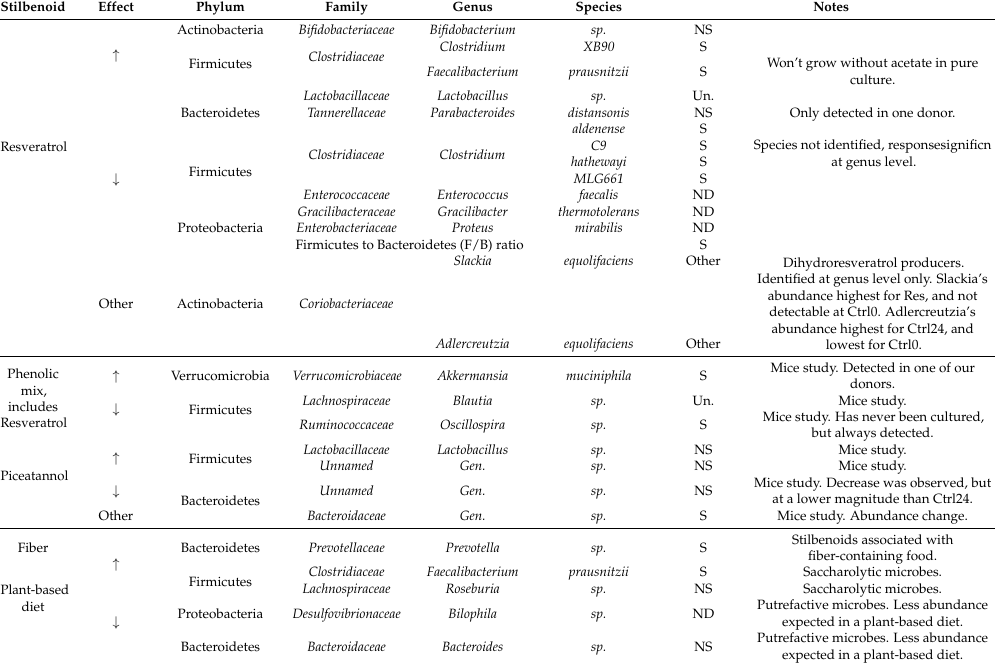
Table 2. Observations from previous studies regarding the effect of select stilbenoids on specific taxa compared to observations in this study [2,7,8,27,30–34,65]. From the literature, ↑ or ↓ indicate a reported abundance increase or decrease of the strain. From this study, S, NS, Un, ND, signify, respectively, supported, not supported, undefined, not detected. Gen. = unnamed genus, sp. = unnamed species.